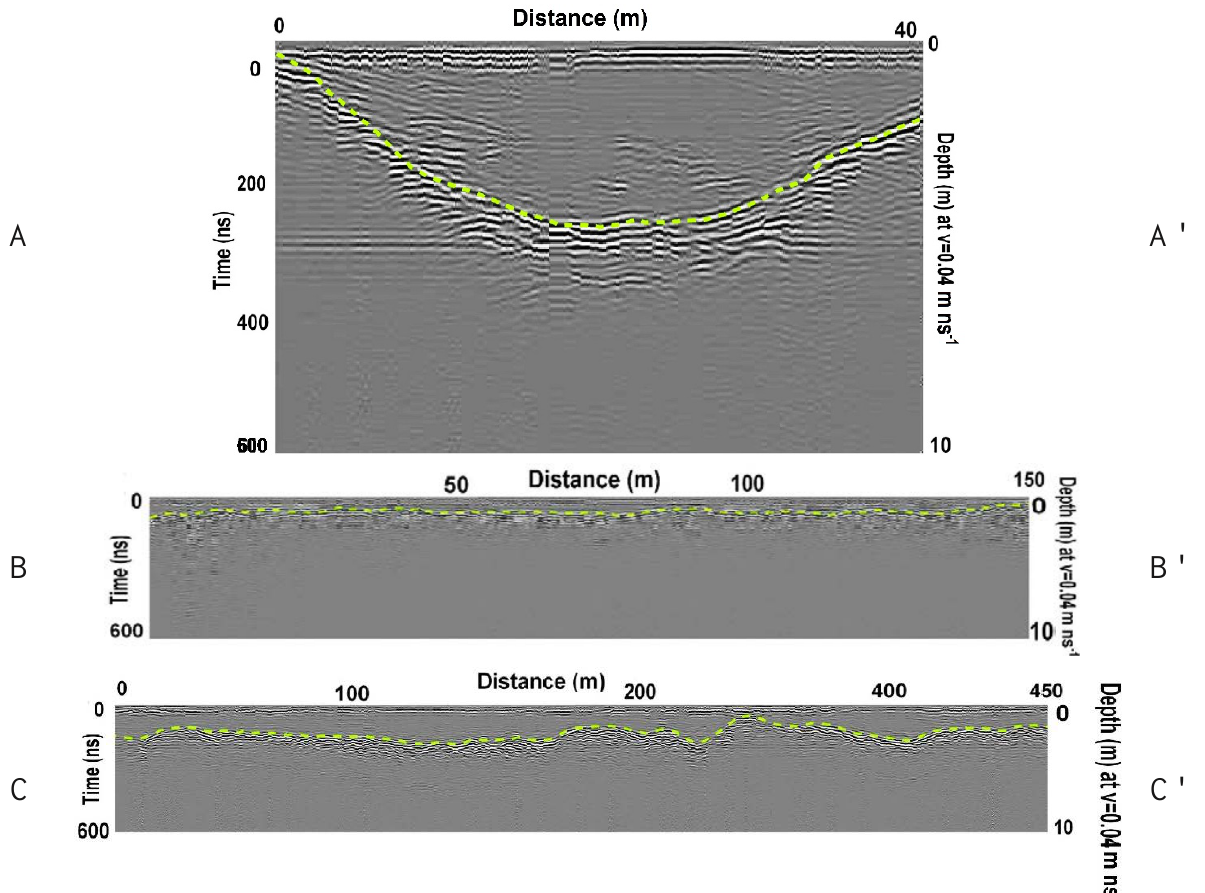
Figure 6. Peat depth profiles of the Criação do Filipe peatland complex on the three transects shown in Figure 3: A–A' (top), B–B' (middle), C–C' (bottom).